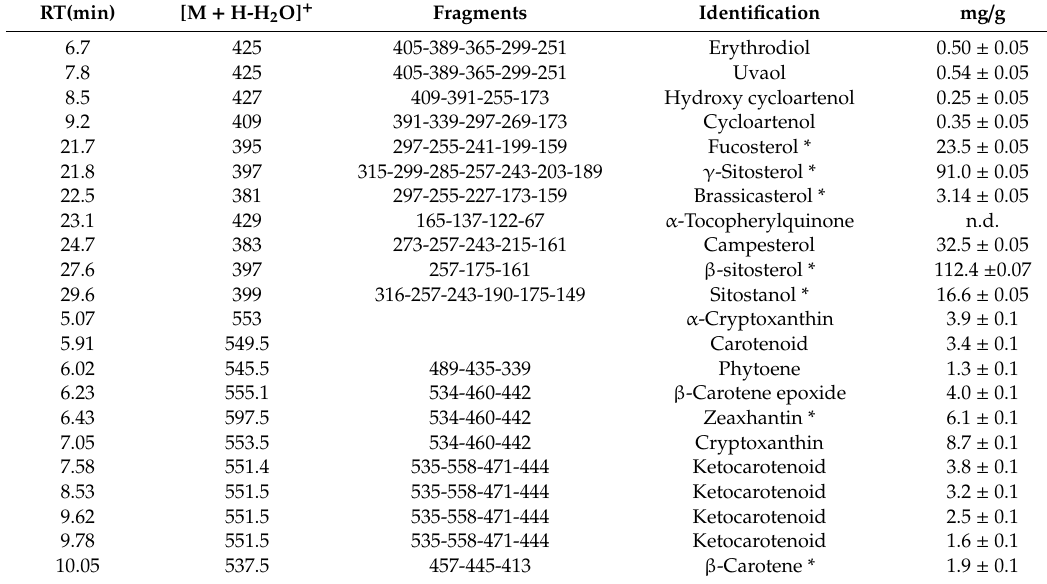
Table 1. Identified lipophilic compounds in G. diversifolia extract by LC-APCI-MS. Compounds were identified on the basis of literature data (CIT) and injection of authentic standards